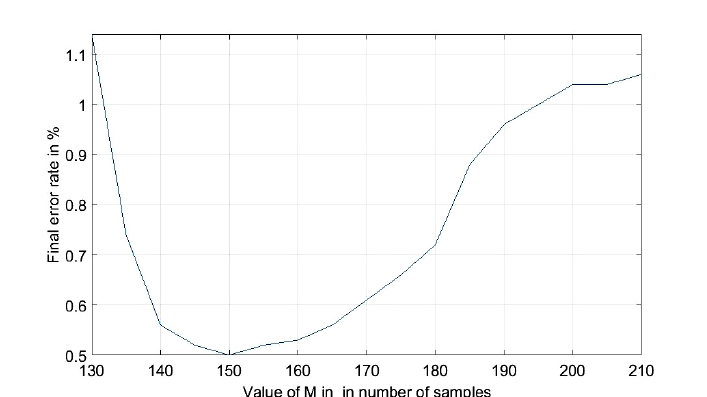
Figure 3. Influence of window length of the dynamic threshold on the overall error rate based on brute force optimization with fixed β = 2.5 and θ =